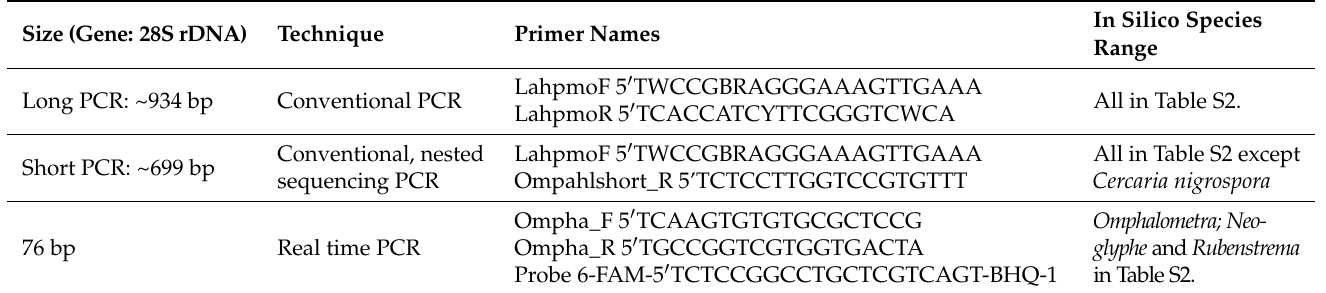
Table 2. Primers to target Omphalometridae and other